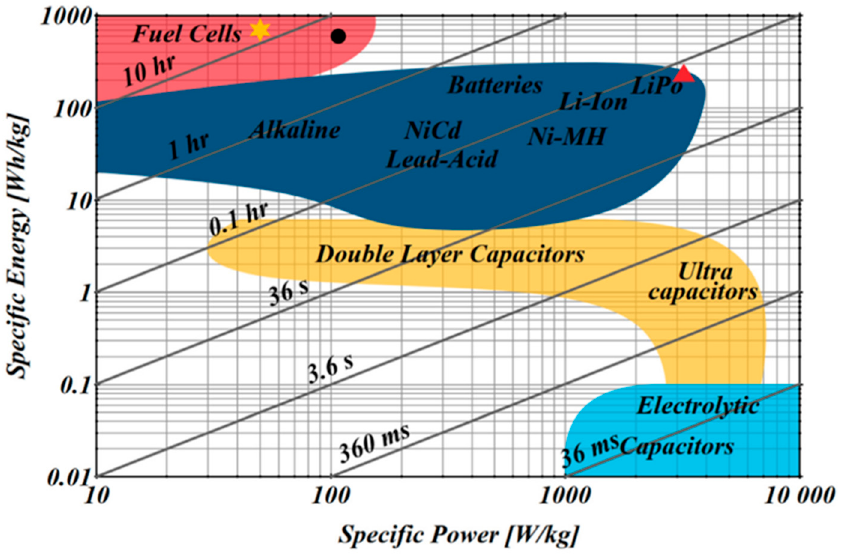
/ power comparison among di ff erent energy Figure 2. Specific energy/power comparison among different energy sources. Figure 2. Specific energy